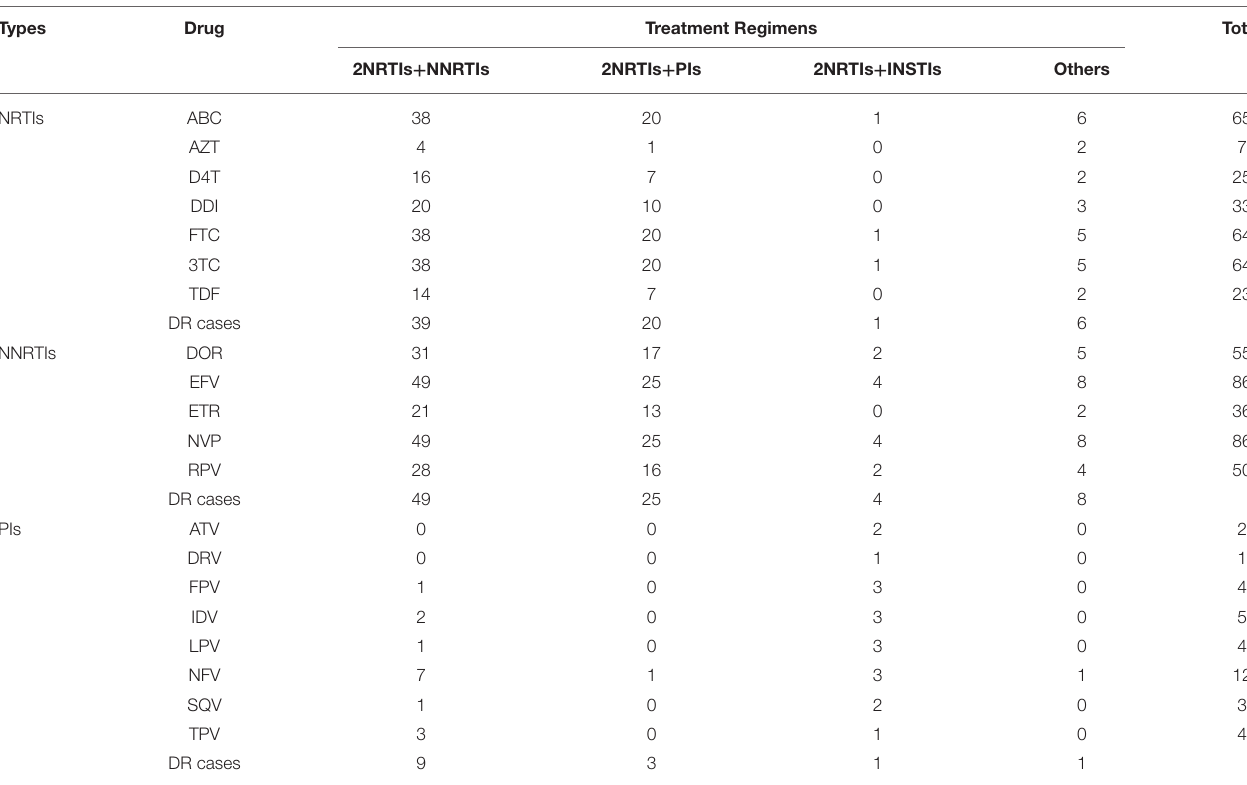
TABLE 4 | Drug resistance profiles in patients with different treatment regimens.